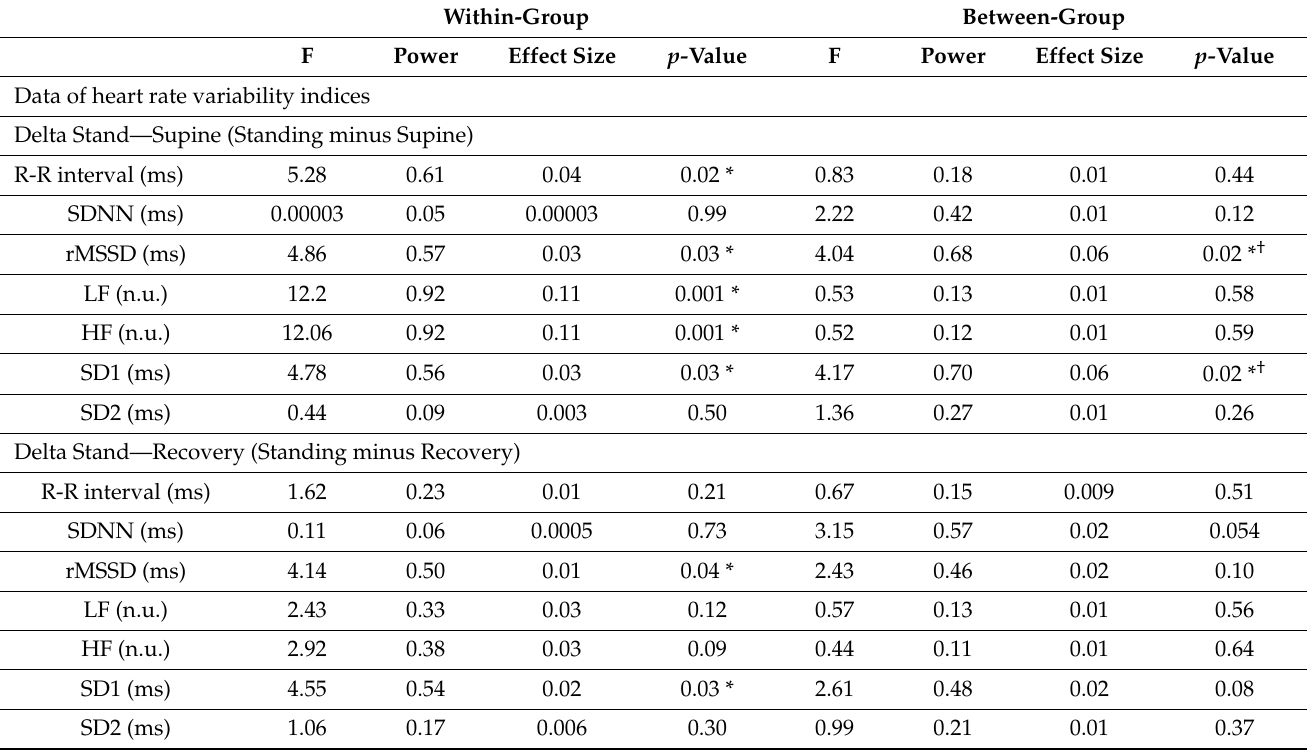
Table 2. Between-group and within-group comparisons considering the delta of Stand and Supine (Standing minus Supine) and Stand and Recovery (Standing minus Recovery) for heart rate variability indices, excluding participants who used beta-blockers (N = 41). Within-Group Between-Group F Power Effect